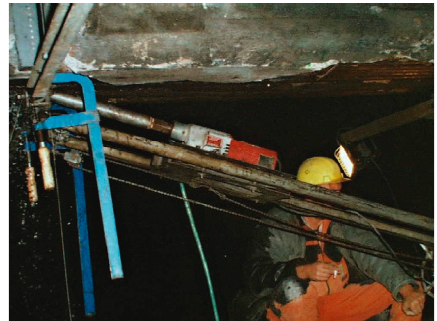
Figure 3: A realization of drilling substitute cable ducts on the bottom side of a U-shaped bridge using a drilling support [21]. The photo shows the use of invented drilling support equipped with a drilling machine with the diamond drilling technology. The drilling machine, clamped into a cart, is led by guiding bars in the required angle (both vertical and horizontal) relative to the bottom face of the structure while drilling a